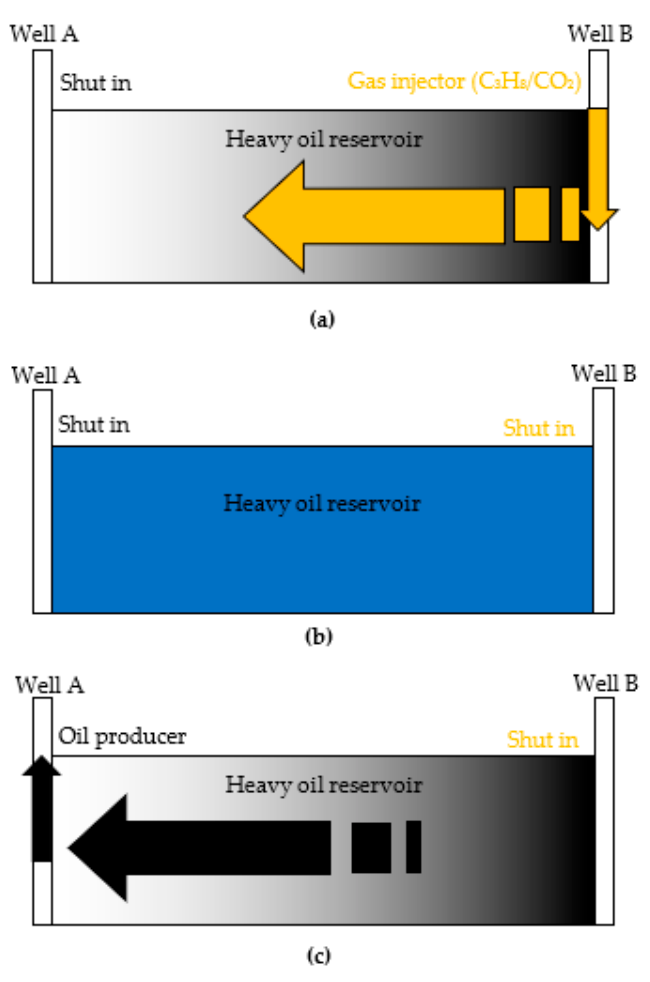
Figure 3. Flow charts of three periods in each cycle of the gas pressure cycling (GPC) process in a two-well configuration: ( a ) gas injection from Well B; ( b ) gas soaking; and ( c ) fluids production from Well A.